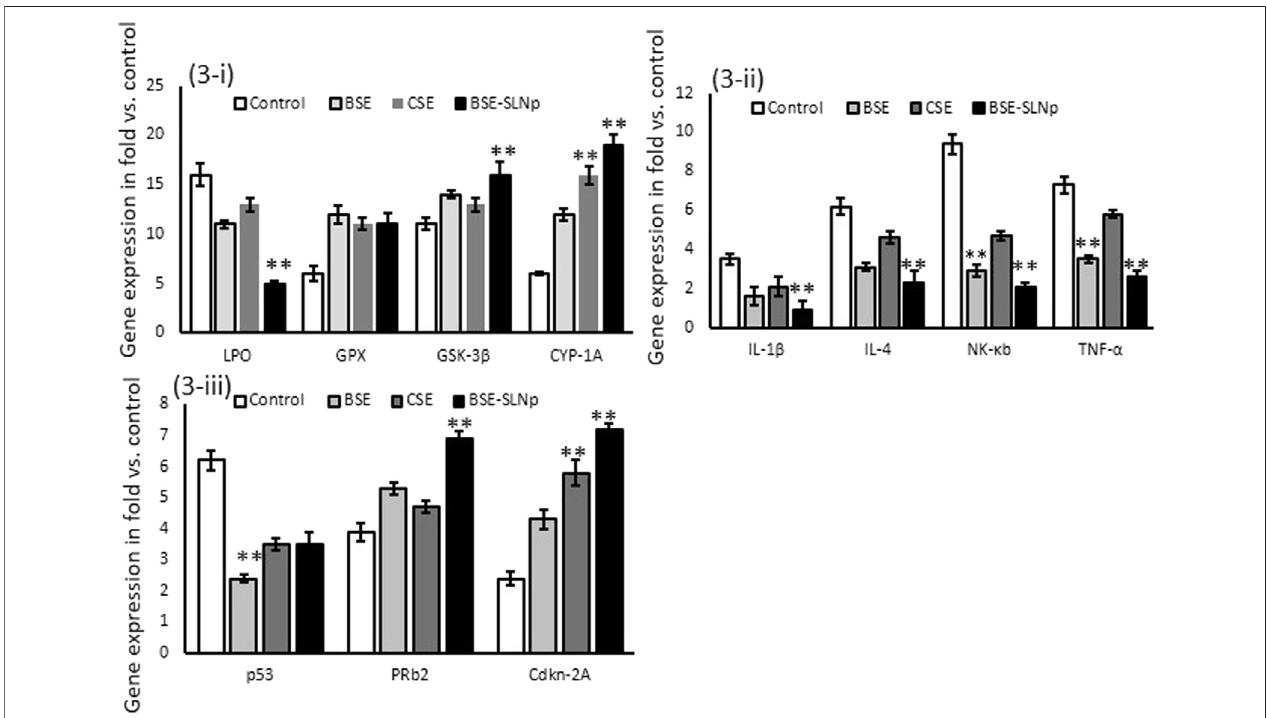
FIGURE3| EffectofBSE,CSE,andBSE-SLNponoxidativestress (3i) ,proin fl ammatory (3ii) ,andtumorsuppressor (3iii) relatedgeneexpressionlevelsinhMSCs after 48 h. Each value is means ± SD ( n (cid:2) 6). ** p ≤ 0.001 by comparison with vehicle control, BSE, and CSE.